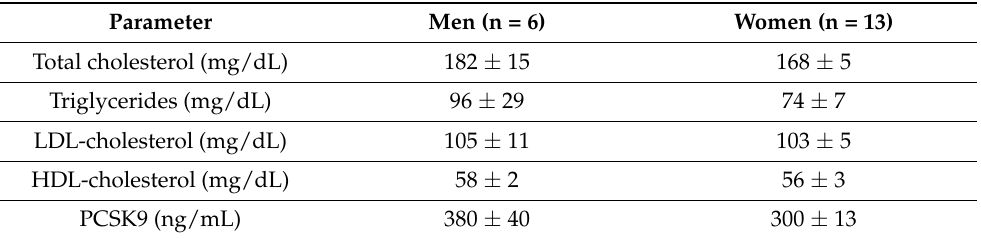
Table 1. Baseline characteristics of the subjects enrolled. Data were reported as mean ± SEM (standard error of the